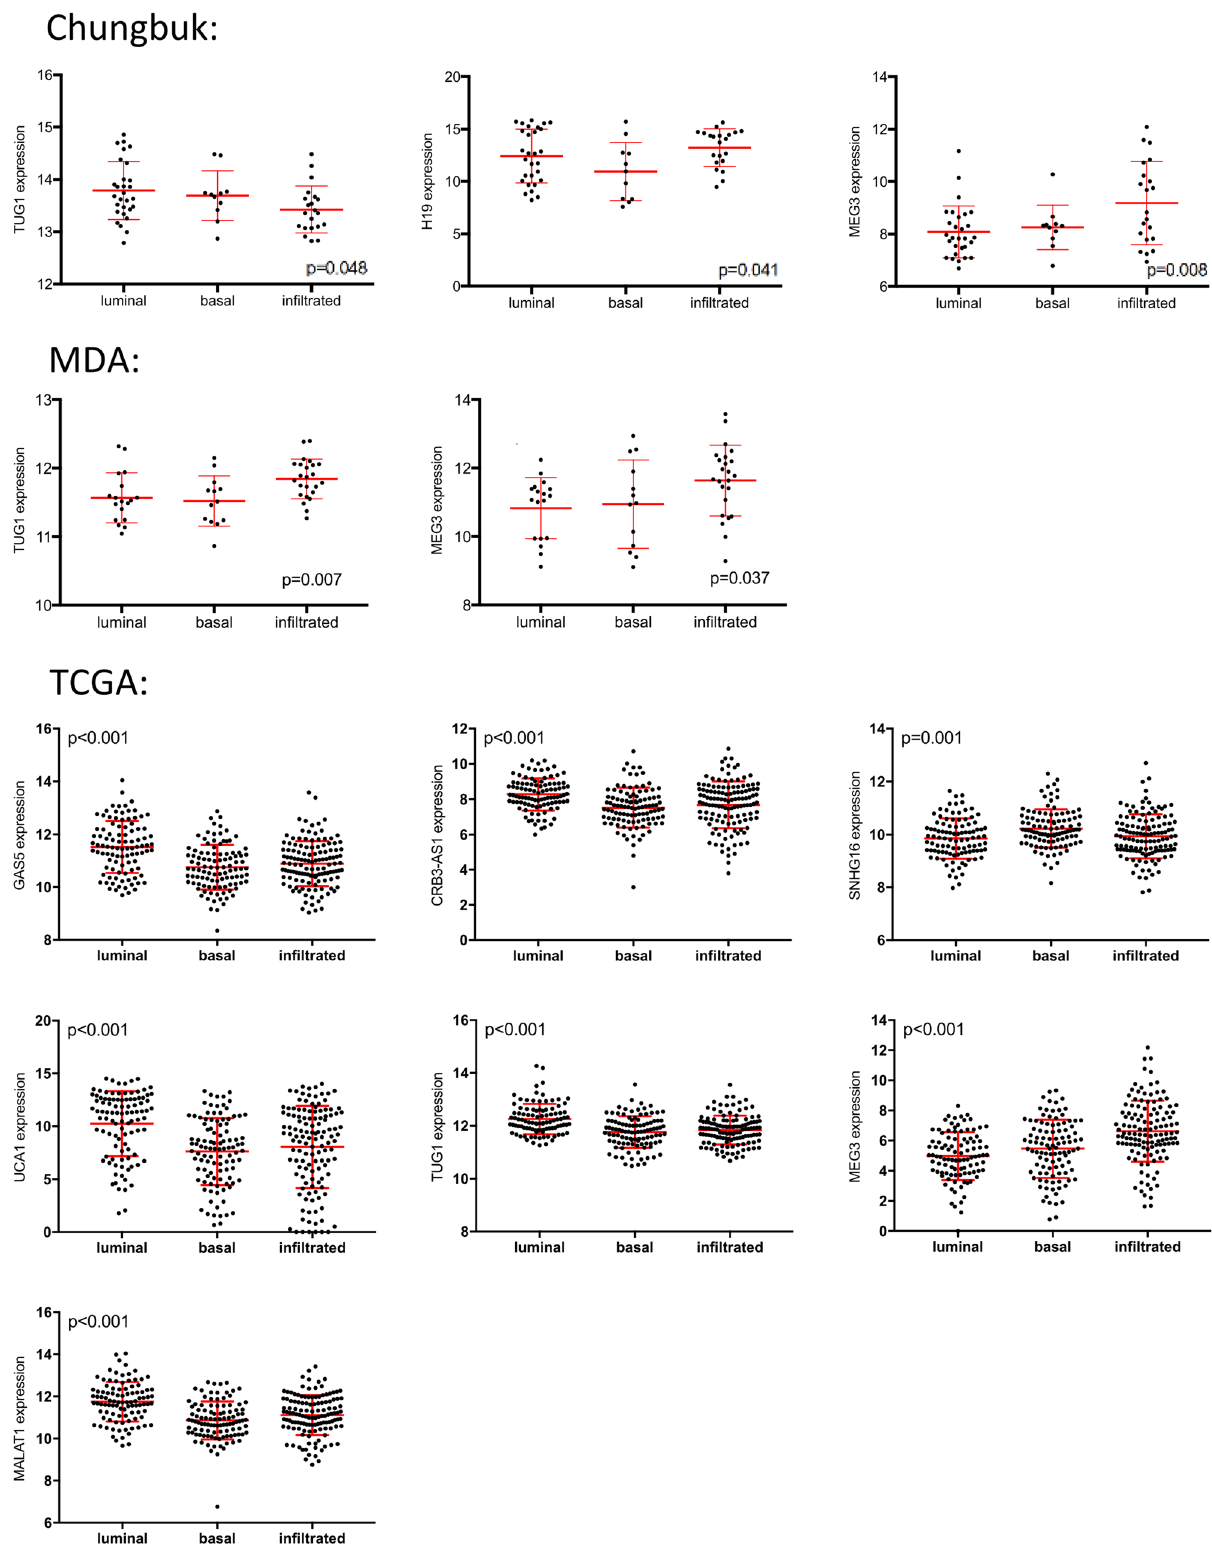
Figure 2. Differential lncRNA expression between the molecular MIBC subtypes based on the Chungbuk (n = 61), MDA (n = 55) and TCGA (n = 371) cohorts. The patients were clustered choosing the same 36-consensus genes than in the Mannheim cohort, as described before 31